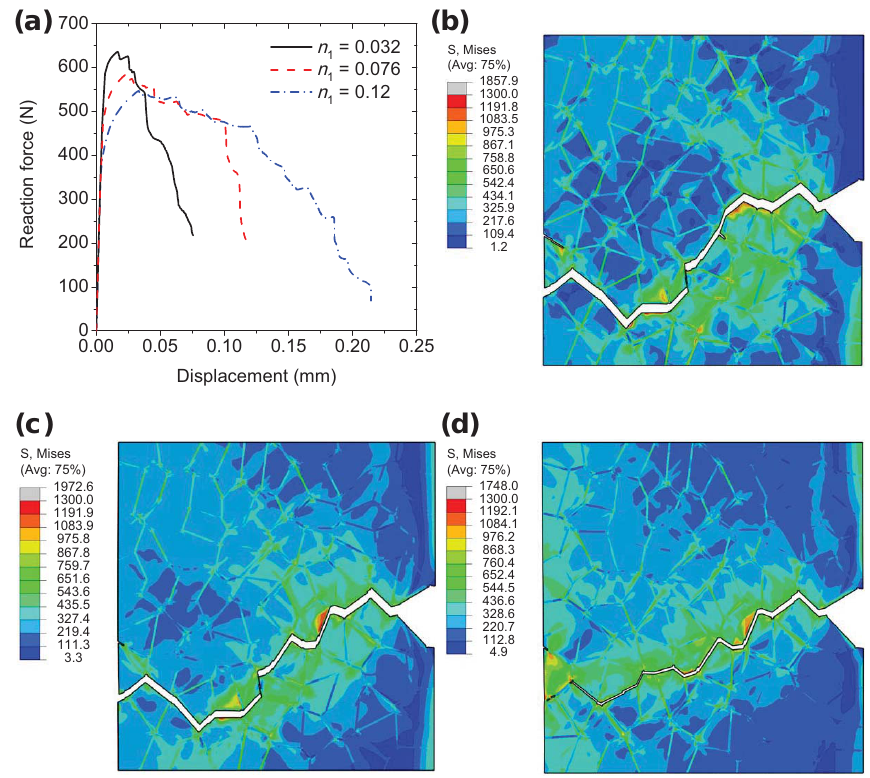
Figure 12. Fracture in a notched-tensile specimen: ( a ) reaction force versus displacement for the different strain hardening exponents; Contour maps in ( b – d ) show the von Mises stress in the grain interiors associated with the different crack propagation paths for ( b ) n 1 = 0.032, ( c ) n 1 = 0.076 and ( d ) n 1 = 0.12,